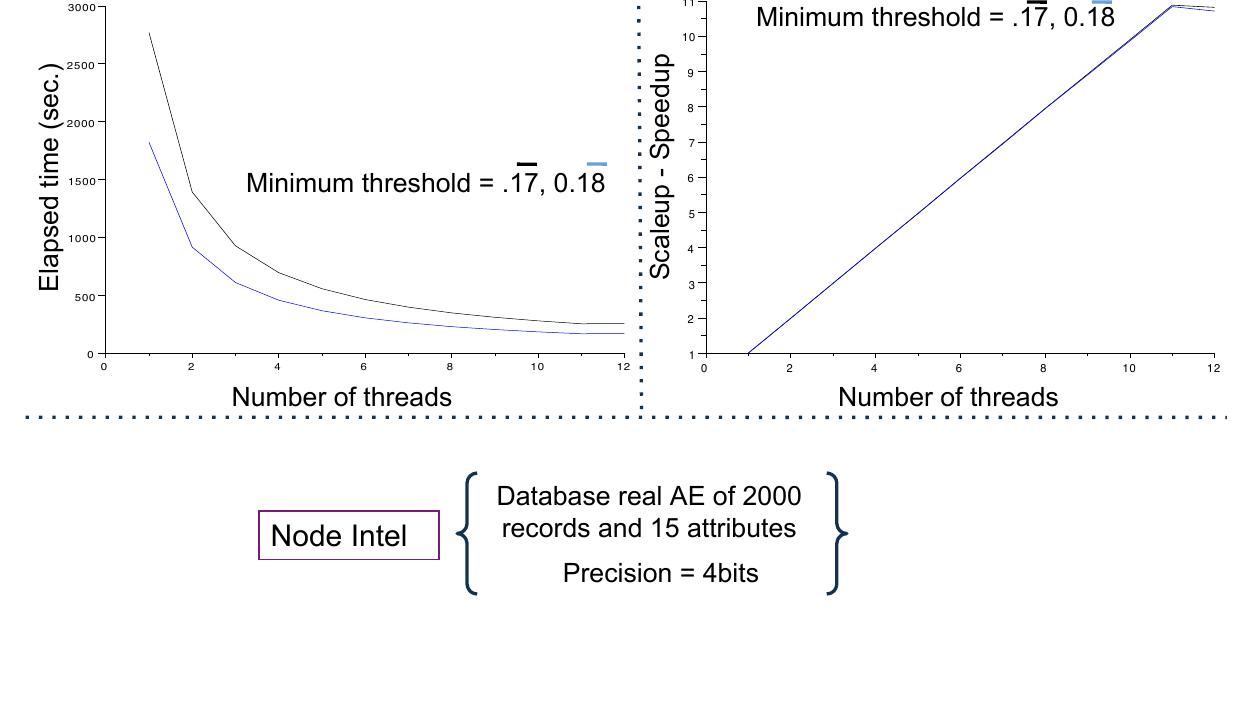
Figure 11. Execution time and Speedup related to the number of threads on Intel nodes for real database of 2000 lines at precision 4 bits with minimum threshold values 0.17 and